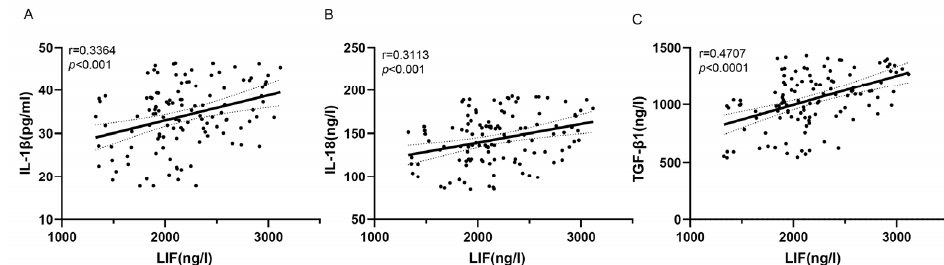
Figure 2. ( A – C ): Correlation analysis between serum LIF and other serum cytokines. ( n = 118) (interleukin (IL), transforming growth factor- β 1 (TGF- β 1)).